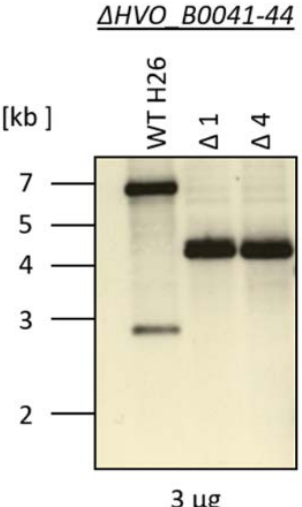
Figure 3. Southern blot analysis of the genomic DNA from the wild-type H26 and from two clones of the iuc gene deletion mutant. The size marker is schematically indicated to the left.